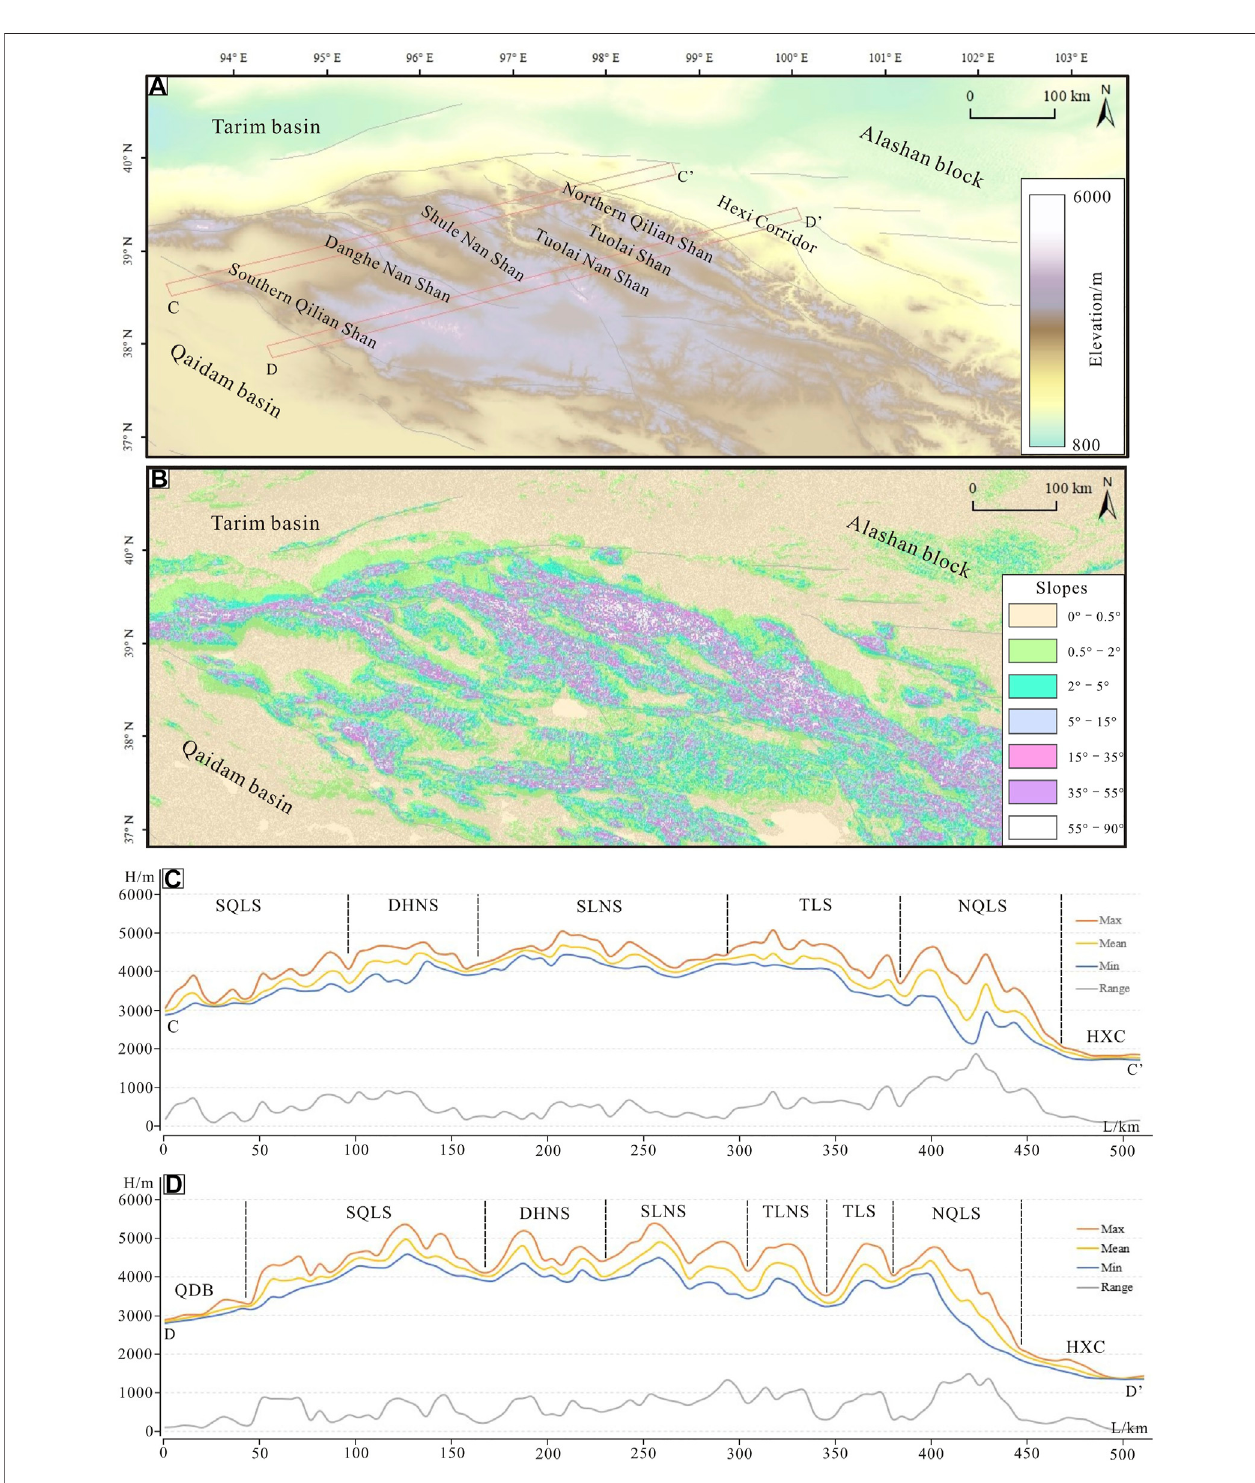
FIGURE 3 | (A) The DEM image of the Qilian Shan. (B) The slope map of the Qilian Shan. The gray lines represent active faults in the Qilian Shan. (C,D) are swath pro fi lesonthewesternQilianShan.Thelocationsoftheswathpro fi lesareshownintheredrectanglesofpanel (A) .TheMax,Mean,Min,andRangecurvesrepresentthe maximum, average, minimum, and standard deviation (difference between the maximum and minimum) of elevations in the swath ranges, respectively. Abbreviations of names: SQLS, Southern Qilian Shan; DHNS, Danghe Nan Shan; SLNS, Shule Nan Shan; TLNS, Tuolai Nan Shan; TLS, Tuolai Shan; NQLS, Northern Qilian Shan; QDB, Qaidam basin; HXC, Hexi Corridor.